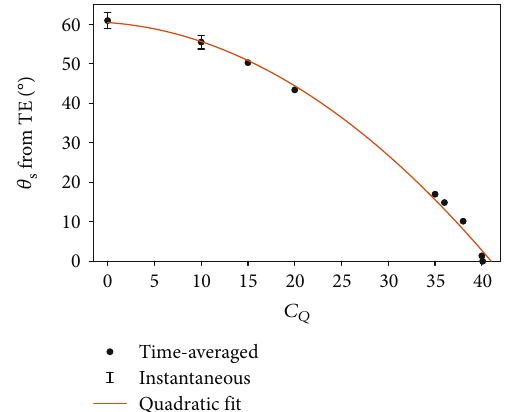
Figure 7: E ff ect of increasing the number of control parameters on optimal